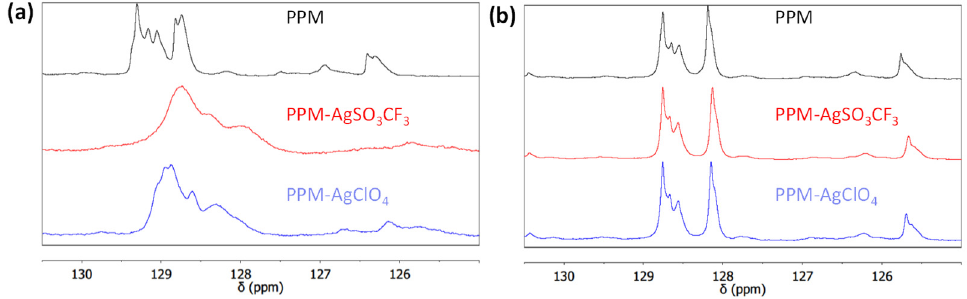
Figure 5. Section of 13 C NMR spectra of the aromatic region of PPM alone and PPM with AgSO 3 CF 3 or AgClO 4 in ( a ) chloroform and ( b ) THF.